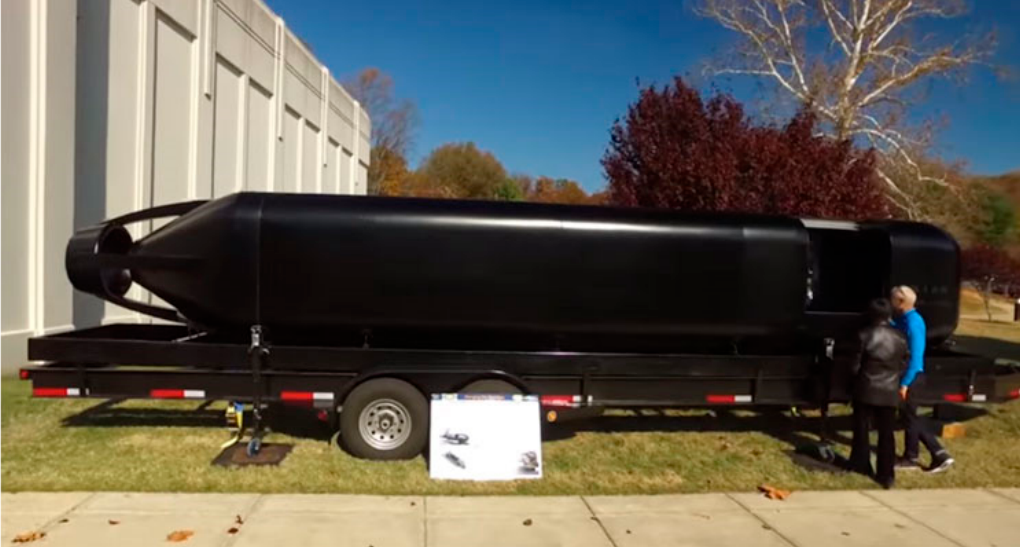
Figure 12. Submarine hull made incremental techniques for the US Navy [41].